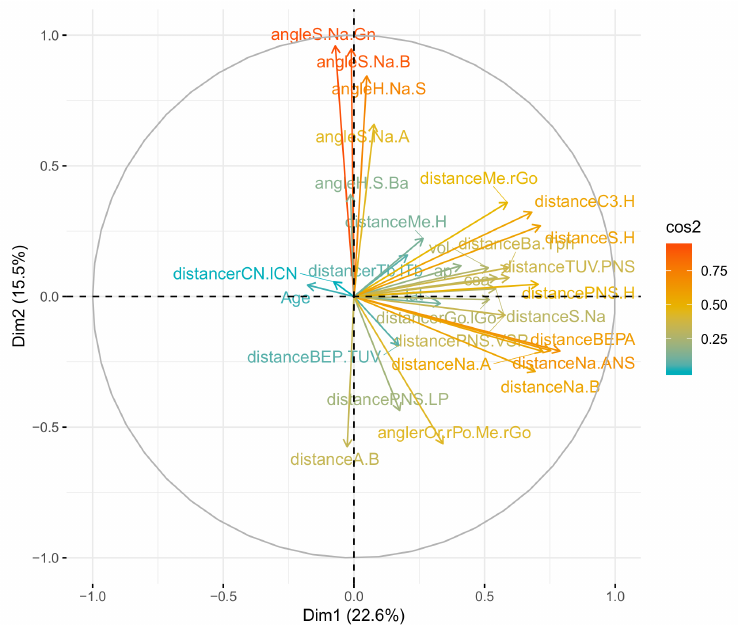
Figure 2. Results of the principal component analysis (PCA) for the dimensions 1 and 2. Variables well represented by the PCA are located next to the periphery of the circle (and have a high value of cos2). Positively correlated variables are found closely, while negatively correlated variables are found in the opposite